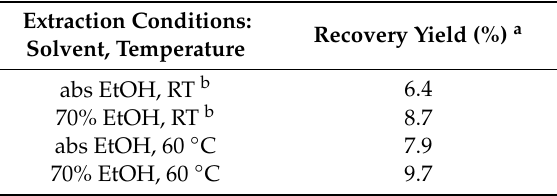
Table 1. Recovery extract